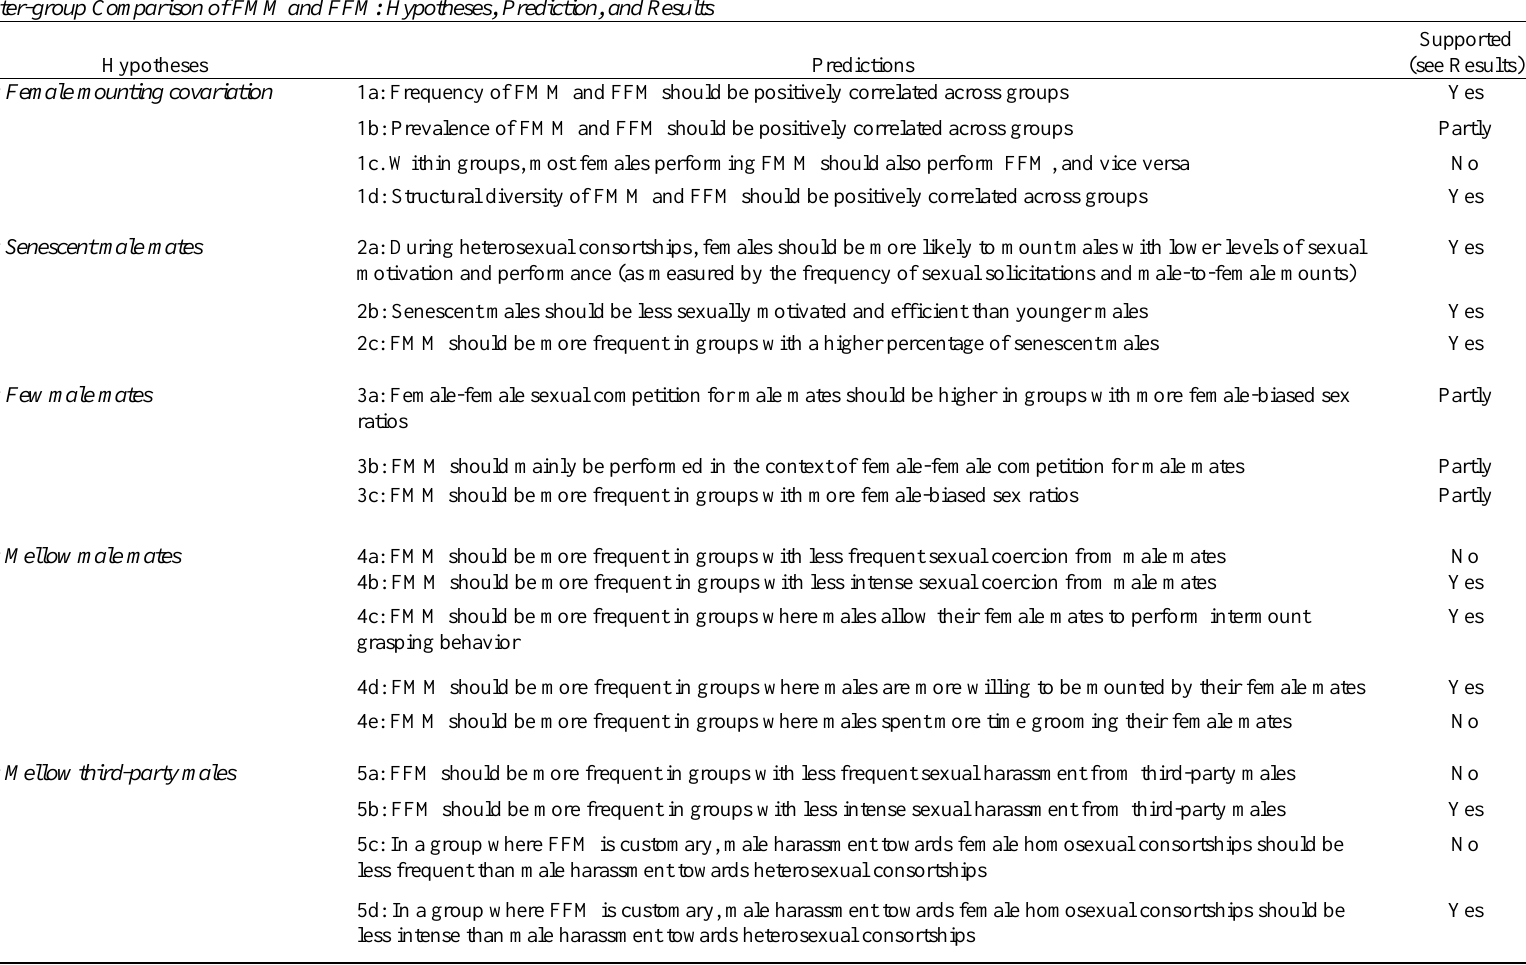
Inter-group Comparison of FMM and FFM: Hypotheses, Prediction, and Results Hypotheses Predictions